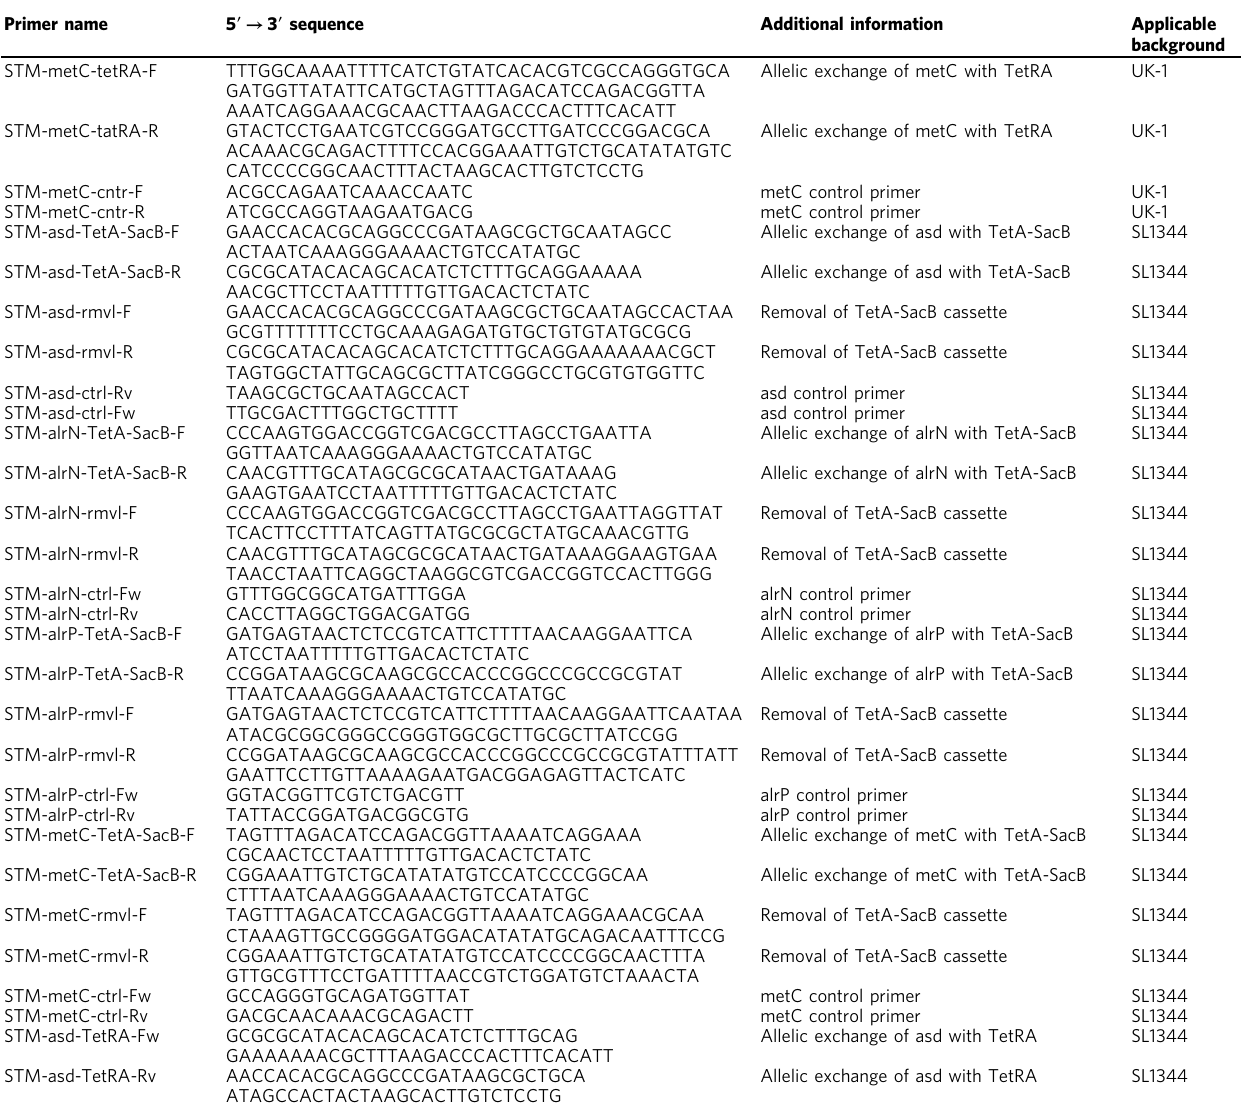
Table 2 Primers used for bacterial